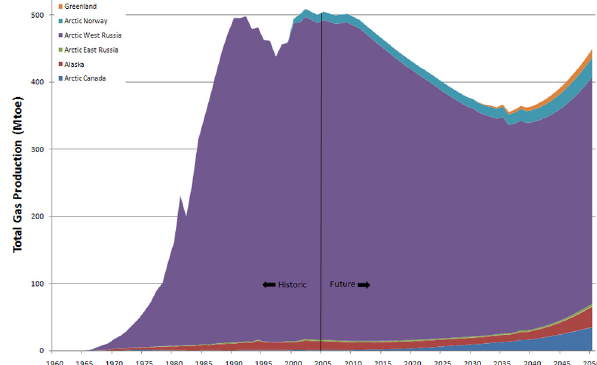
Fig. 3. Historic and estimated gas production in the